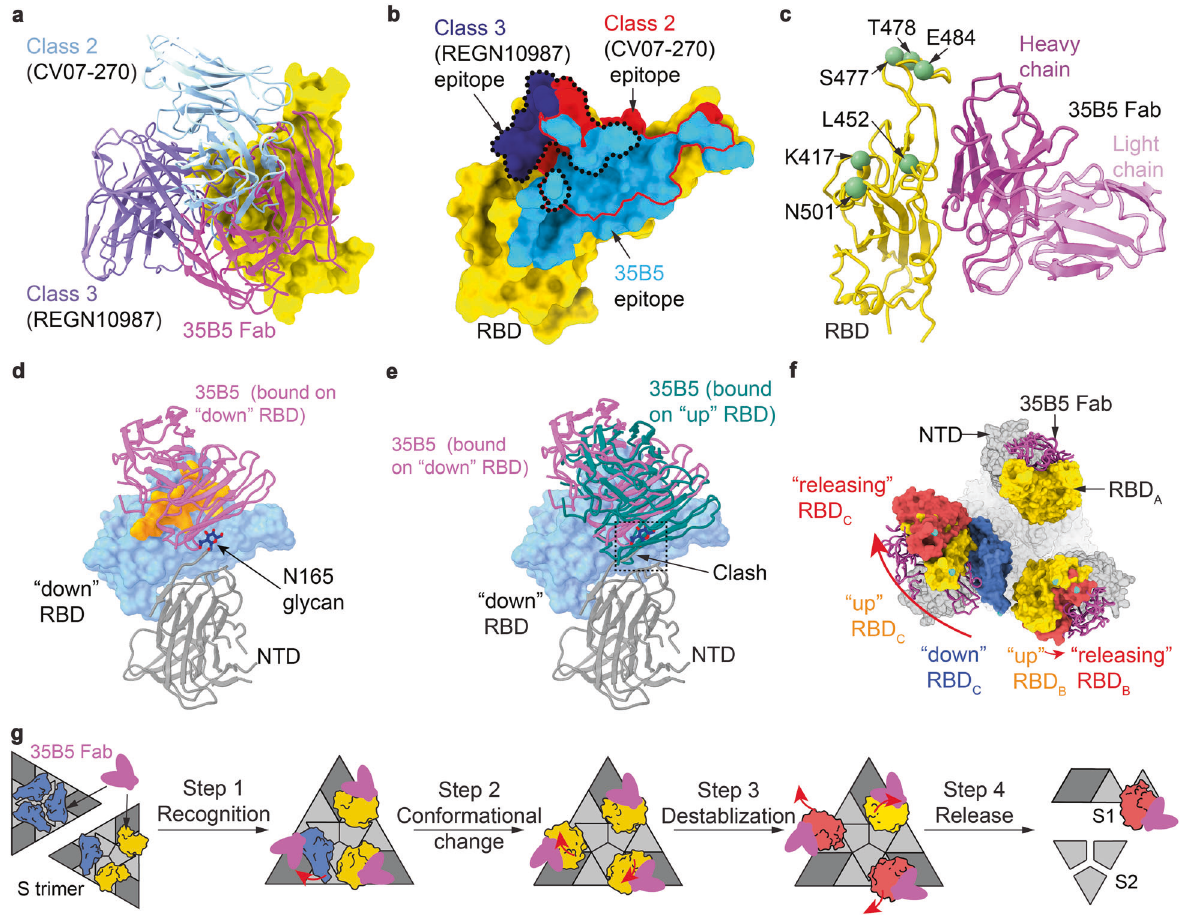
Fig. 4 Structural basis and neutralizing mechanism for the broad neutralizing activities of 35B5 to the SARS-CoV-2 variants. a Structural comparisons of the 35B5 Fab- “ up ” RBD interactions with those of the previously identi fi ed Class 2 and 3 neutralizing antibodies. 35B5 Fab and the Fab regions of the representative antibodies CV07-270 and REGN10987 from Class 2 and 3, respectively, are illustrated in cartoon and colored as indicated. RBD is represented as surface in yellow. b Comparison of the epitope of 35B5 with those of the representative neutralizing antibodies of Class 2 and 3 on RBD. The 35B5 epitope is colored in cyan. The epitopes of CV07-270 (Class 2) and REGN10987 (Class 3) are labeled using red and black lines, respectively. c Mapping of the frequently mutated residues of the spike protein in the recent SARS- CoV-2 variant in the 35B5 Fab-RBD structure. RBD and 35B5 Fab are shown in cartoon and colored in yellow and purple, respectively. The frequently mutated residues in RBD in the recent SARS-CoV-2 variant are highlighted with green spheres. d Interactions of 35B5 Fab with the “ down ” RBD. 35B5 Fab, the “ down ” RBD, and NTD domains are colored in purple, cyan, and gray, respectively. The 35B5 Fab-interacting region on RBD is highlighted in orange. e Structural clashes between 35B5 Fab and the NTD domain upon structural superimposition of the “ up ” RBD-35B5 Fab model with the “ down ” RBD-35B5 Fab region in the state 1 S-6P-35B5 Fab complex. The structural clashes are highlighted with dashed lines. f Conformational changes of the RBD domains upon 35B5 Fab binding. The S-6P-35B5 Fab complex structures of three states were superimposed. 35B5 Fabs are shown in the cartoon in purple. The “ down ” , “ up ” , and “ releasing ” RBD domains are colored in blue, yellow, and red, respectively. The conformational changes of RBDs are indicated with arrows. g Schematic diagram of the neutralizing mechanism